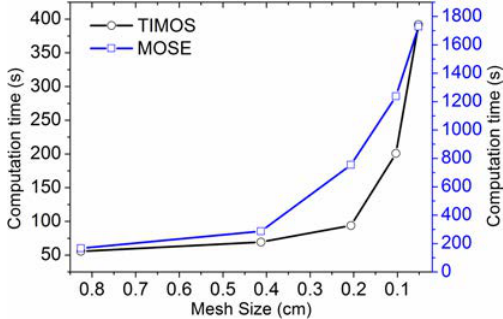
Fig. 6. Simulation time of TIMOS and MOSE as a function of mesh size.